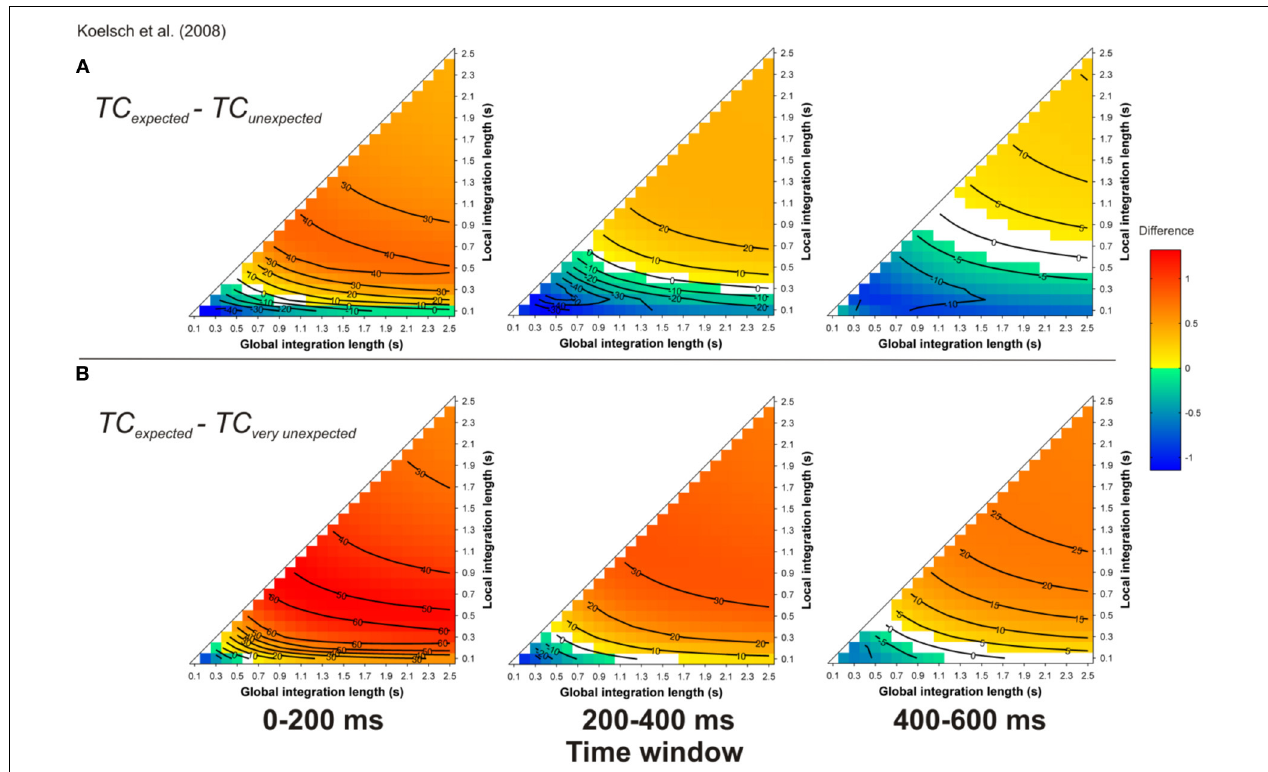
FIGURE 10 | Simulation of Koelsch et al. (2008). Mean TC differences between expected vs. unexpected (A) and vs. very unexpected (B) target chords, as a function of the local and global context integration windows. Positive, negative, and nonsignificant differences are represented by hot,